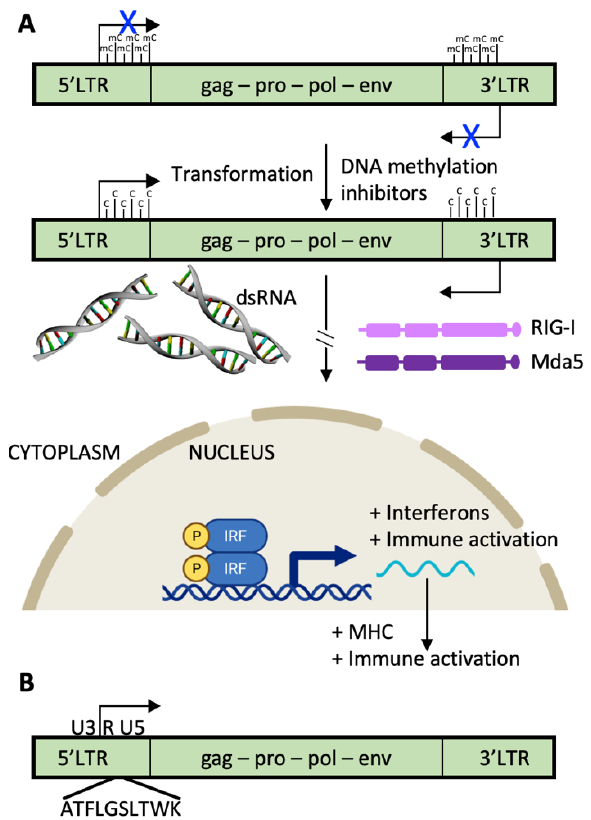
Figure 3. HERVs with productive open reading frames are a source of cellular and humoral tumor antigens. ( A ) The long terminal repeat sequences (LTRs) of most human endogenous retroviruses (HERVs) that express proteins are silenced by epigenetic methylation and demethylated during the transformation process. Since the LTRs transcribe the same sequences in opposite directions, double-stranded HERV RNA molecules are formed, activating cytosolic pattern recognition receptors such as RIG-I and MDA5, leading to activation of the signaling pathways of Type 1 Interferons, and increasing antitumor immunity by upregulation of MHC molecules. ( B ) Example of a HERV tumor antigen expressed in clear cell renal cancers and recognized by cytotoxic T cells is shown. A HERV-E, found on chromosome 6q, harbors the HLA-A11-restricted CT-RCC antigen in the second reading frame downstream of the transcriptional start site in the 5′ LTR (peptide identified in [68]). HERV-E is so-named because the tRNA “primer binding site” of the retrovirus is glutamic acid (single letter code is E). gag, capsid region; pro, protease region; pol, polymerase region; env, envelope region. U3 and U5 are the “Unique” regions of the LTRs containing retroviral enhancers, promoter, transcription start sites, and poly-adenylation sites; R is the “Repeated” region required for proviral DNA synthesis.